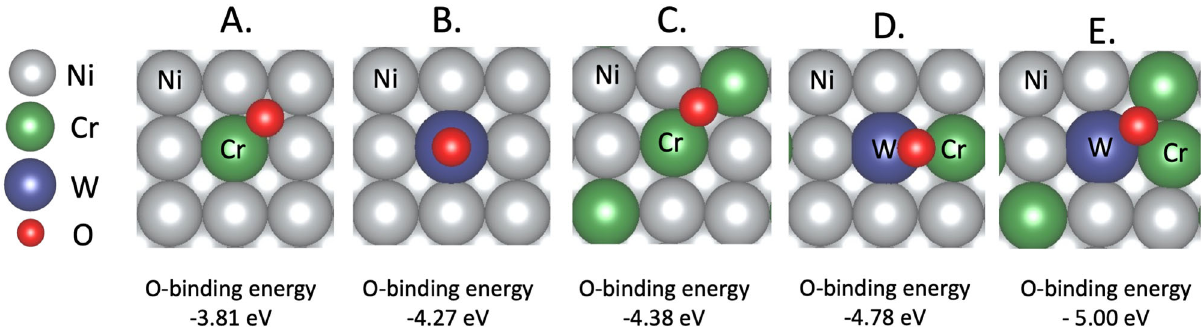
Fig. 8 O-adsorption sites. Summary of the most stable adsorption sites for atomic oxygen on different surfaces as calculated with DFT for FCC surfaces with one to four non-Ni atoms. Labeled n/m where n is the number of non-Ni atoms and m = 9 as the number of surface atoms. The fi gures are arranged in order of O binding energy from the weakest ( A ) to the strongest binding energy ( E ) A at 1/9 Cr surface alloy and the lowest energy adsorption site is at the Ni-Cr 4-fold site; B at 1/9 W surface alloy the on-top O site is most stable; C a 3/9 Cr surface alloy and the Cr-Ni-Cr hollow site is most stable; D at 2/9 Cr/W surface alloy with the bridge site between W and Cr as the energetically favorable site; E at 4/9 Cr/W surface alloy a W-Cr-Cr hollow site is most stable. This is also the overall most stable con fi guration of the three